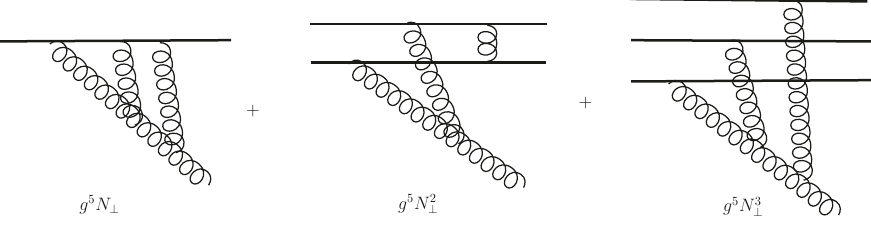
Figure 2 . Schematic diagrams showing perturbative corrections to small- x gluon distribution at order g 5 . Saturation correction at order g 5 only considers the types of diagrams proportional to g 5 N 3 ⊥